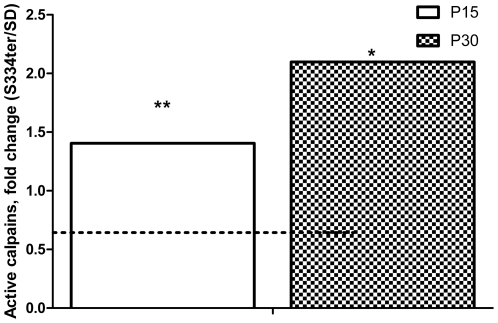
Activation of calpains in S334ter-4 Rho retinas.In P15 and P30 S334ter-4 Rho retinas, we observed an activation of calpains in the cytosol measured by the fluorescence intensity emitted from the calpain substrate Ac-LLY AFC. On P15 and P30, there was a 1.4- and a greater than 2-fold increase in activated calpains in S334ter-4 Rho retinas compared with SD retinas, respectively (2.24±0.09 in SD vs. 3.1±0.127 in S334ter-4 Rho, P<0.01 and 1.287±0.27 in SD vs. 2.7±0.04 in S334ter-4 Rho, P<0.05, respectively).